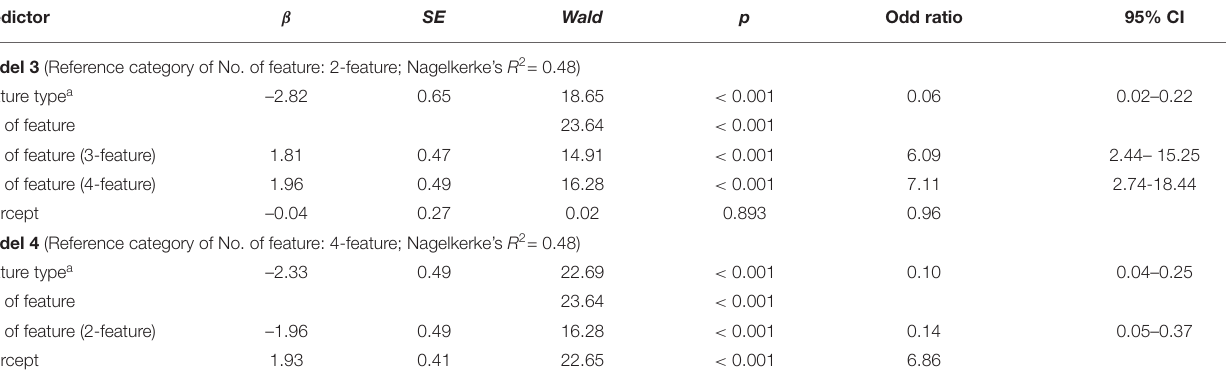
TABLE 8 | (Formal study) Significant effects of feature type and the number of features on User Interest in the Recommendation (“Interested in” =1, “Not interested in” = 0) in the Text condition by logistic regression. Predictor β SE Wald p